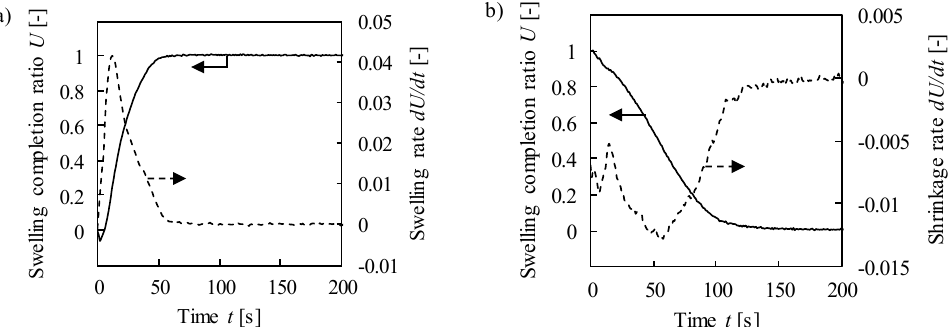
Figure 2. Time change of swelling completion ratio and its rate during ( a ) absorption under 0.518 MPa and ( b ) following discharge.